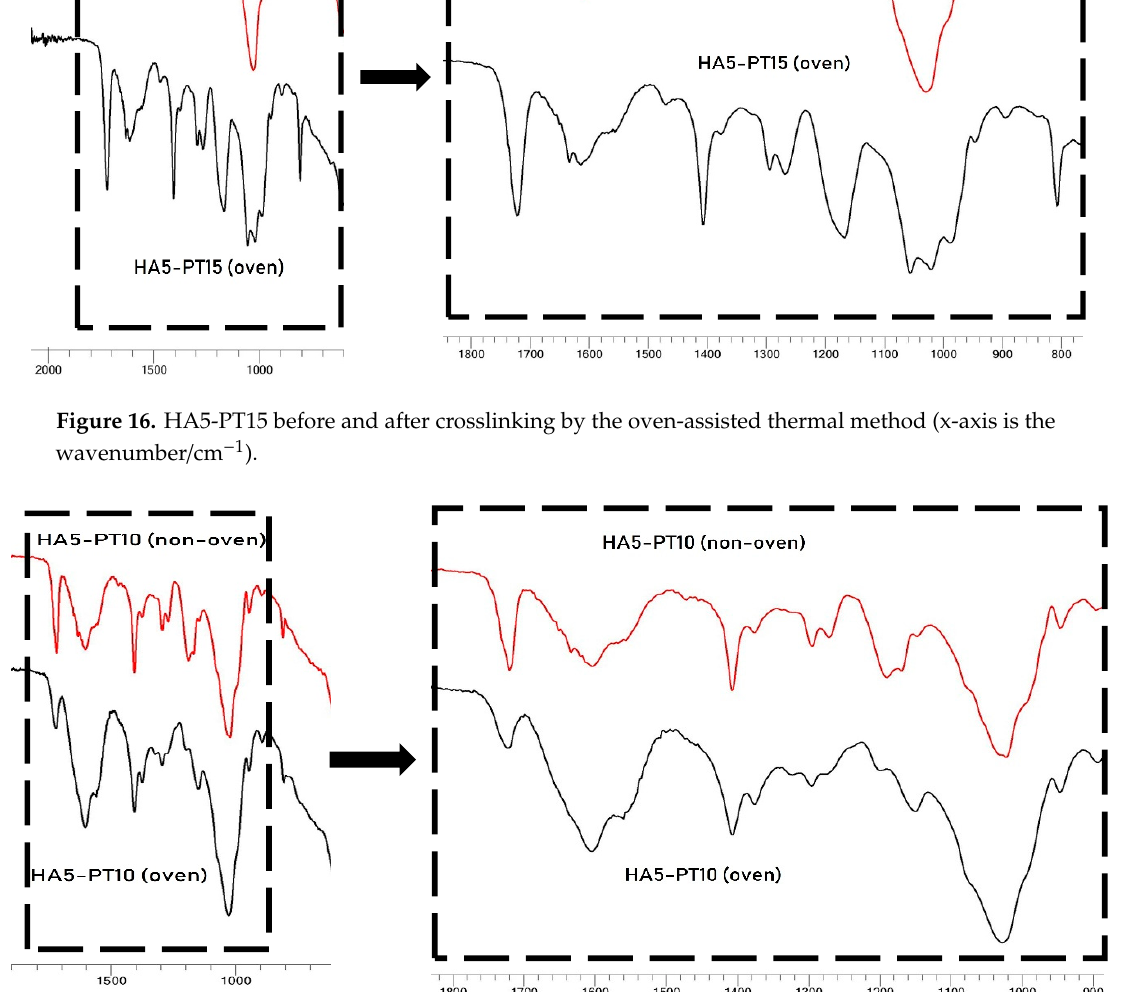
Figure 17. HA5-PT10 before and after crosslinking by the oven-assisted thermal method (x-axis is the wavenumber/cm − 1 ).